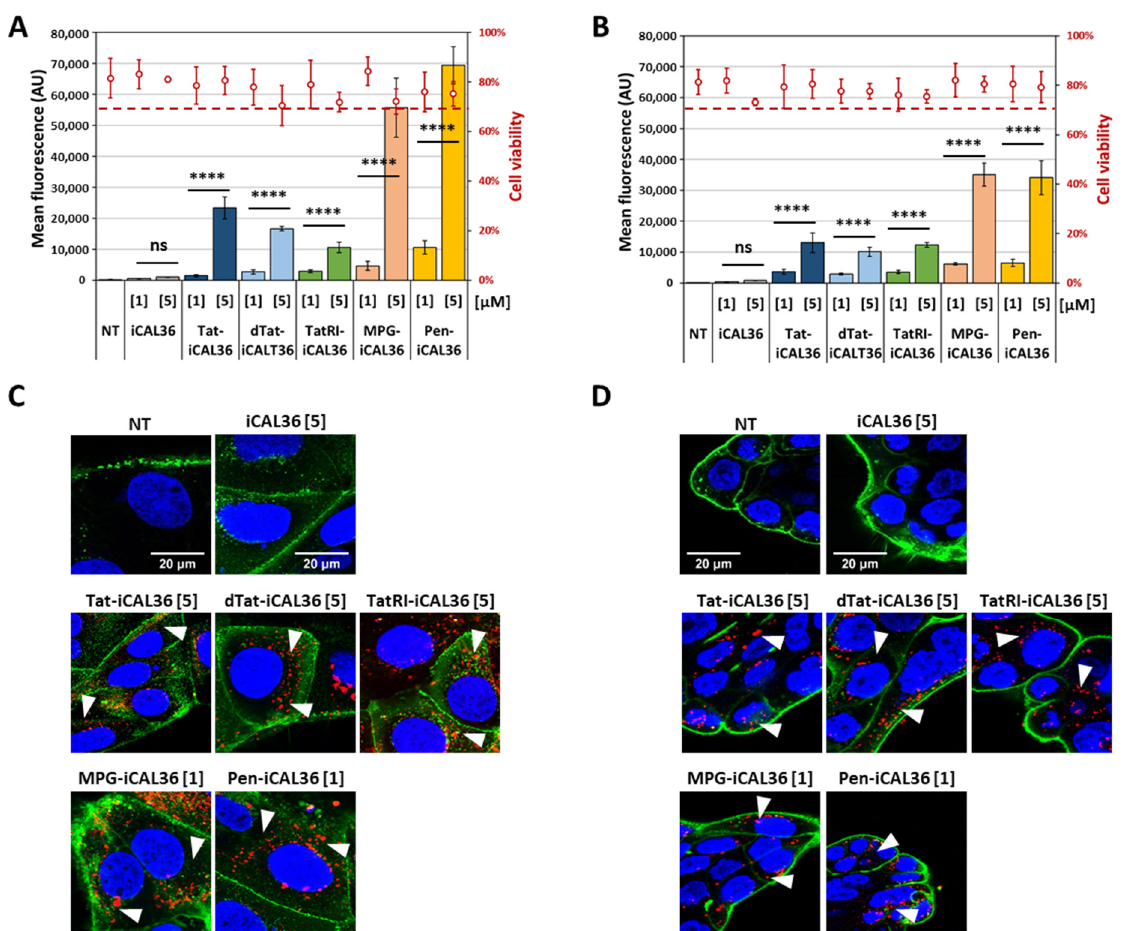
Figure 1. Comparison of CPP-iCAL36 internalization and cellular localization. ( A ) Caco-2 and ( B ) Calu-3 cells were incubated with Tamra-iCAL36 or Tamra-CPP-iCAL36 solutions (1 μ M = [1] or 5 μ M = [5]) in OptiMEM for 1.5 h and compared to non-treated cells (NT). After cell trypsinization (to remove membrane externally bound peptides), fluorescence and cell viability were assessed via flow cytometry. Graphical representation of data obtained from four independent measurements (mean ± SD, n = 4). A statistically significant difference was noticed between the two different used concentrations for all CPP-iCAL36 peptides (one-way ANOVA with Bonferroni test, statistical relevance given as **** p < 0.0001 and ns > 0.05). Living ( C ) Caco-2 and ( D ) Calu-3 cells were imaged by confocal laser scanning microscopy (CLSM) after 3 h incubation with the Tamra-iCAL36 and Tamra-CPP-iCAL36 peptides (red, see white arrows) at the indicated concentrations (1 μ M = [1] or 5 μ M = [5]) in OptiMEM. Next, 10 min before the end of the incubation, Hoechst dye (blue = nuclei) and WGA-Alexa488 (green = cell membrane) were added. Cells were washed and covered with DMEM FluoroBrite before imaging. White bars represent 20 μ m. The results of the Tat-iCAL36 (1 μ M = [1]) and MPG-iCAL36 (1 μ M = [1]) peptides on Caco-2 cells were previously reported [25].